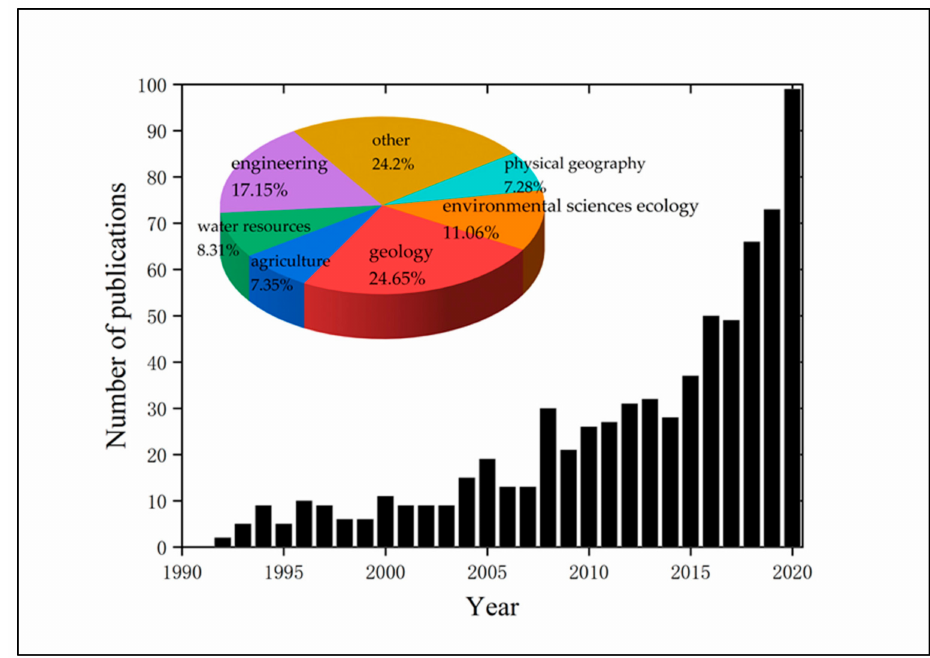
Figure 1. Number of annual publication on unfrozen water in frozen soils (UWFS) from January 1992 to December 2020 of Web of Science Core Collection. The pie chart is the top six major research